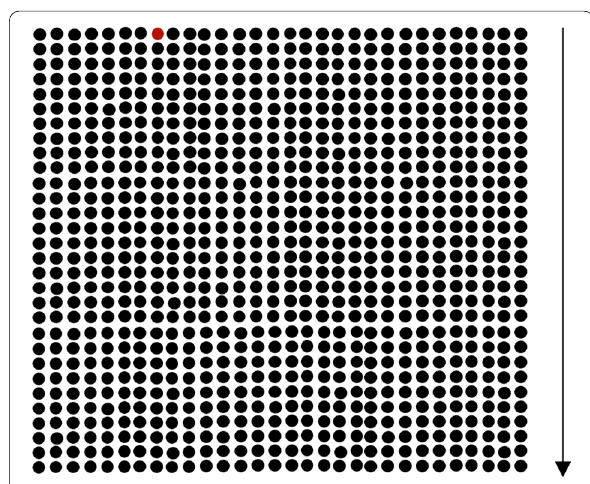
Fig. 1 An icon array illustrating the 1 (red dot) in 900 chance of experiencing a side effect due to a treatment. The icon array in Experiment contained 1 million dots, one of them red, that participants had to scroll through if assigned to a visualization condition. The arrow on the right represents how participants had to scroll through the array of dots, but this arrow was not part of